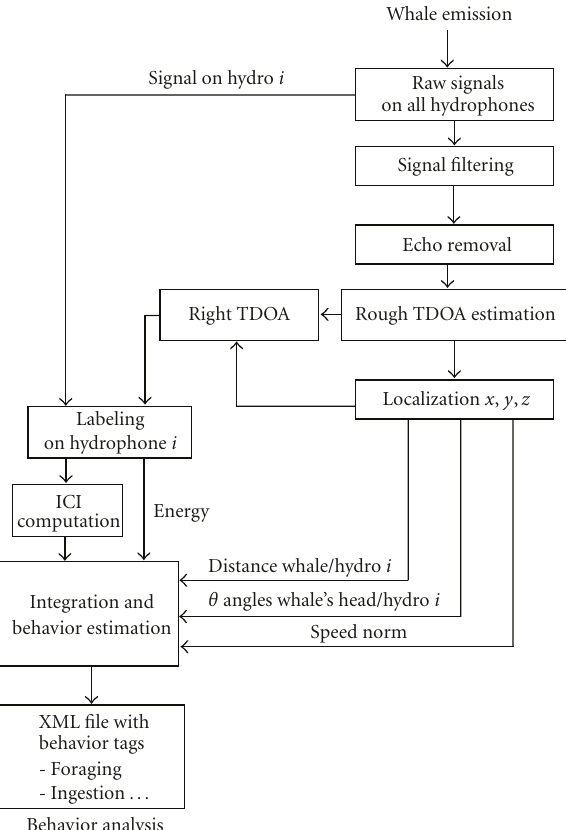
Figure 6: Block scheme of the features extraction. The forward arrow of the localization box points the robust TDOA